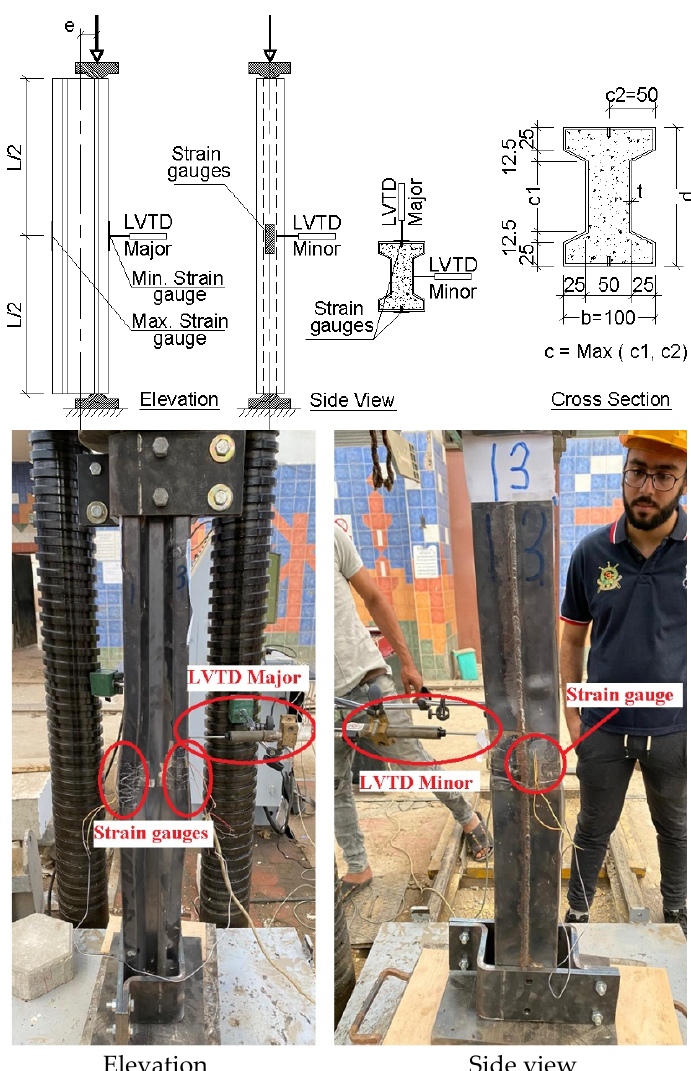
Figure 3. Testing setup, instrumentation and typical dimensions of specimen cross section.